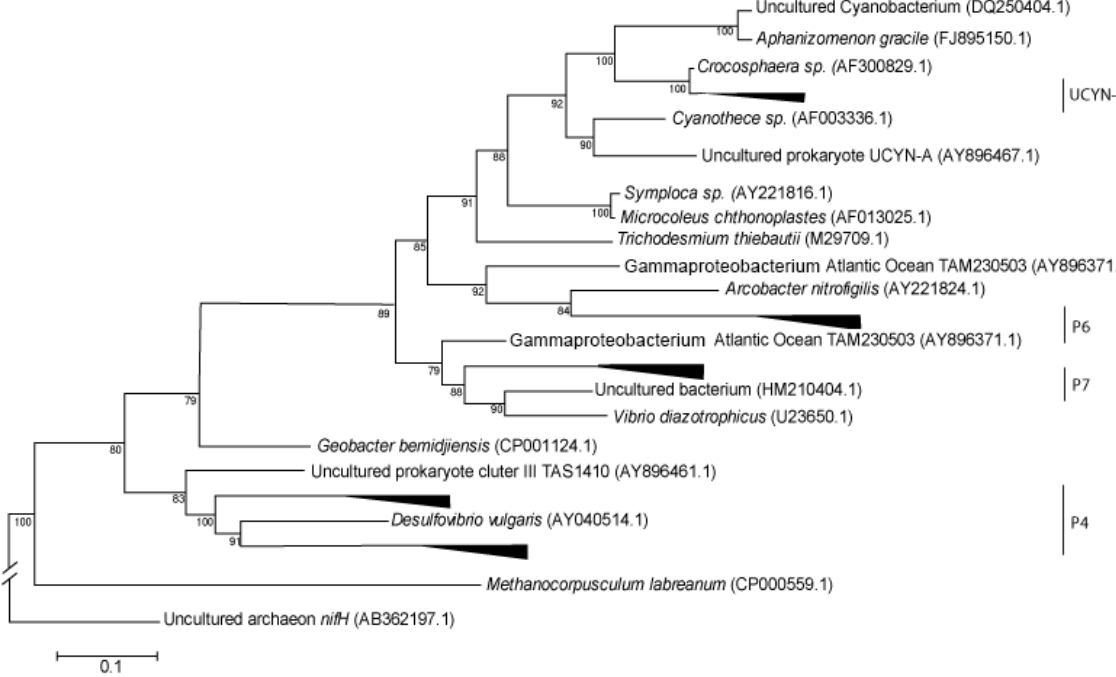
Figure 4. Phylogenetic diversity in nifH cDNA libraries. Black triangles denote detected clusters present in samples from M90 and M91. The tree was constructed from a ClustalW alignment as a neighbor joining tree; bootstrap values are given (% of 1000 bootstraps) below branches; P4, P6 and P7 are clusters previously identified in that region (Löscher et al., 2014).